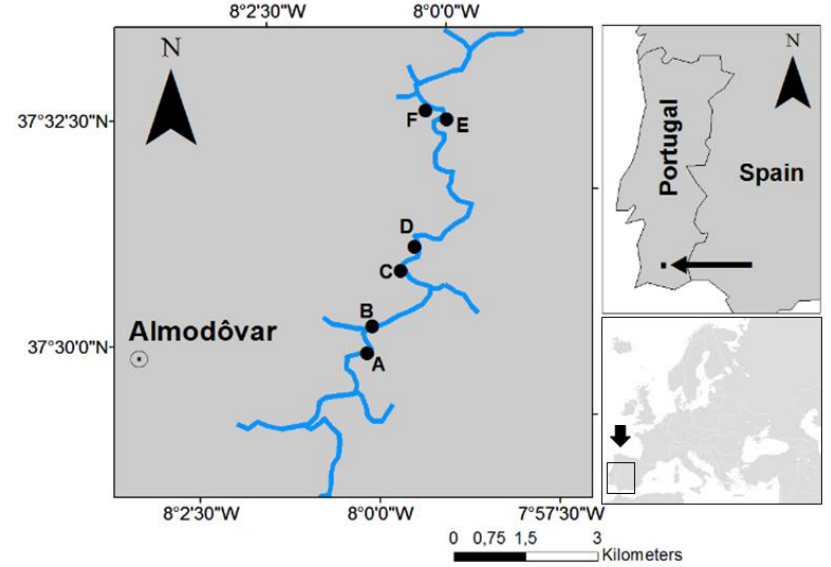
Figure 1. Location of the six permanent pools in the Oeiras river, flowing north in this section. Ossada Montante ( A ), Monte Ossada ( B ), Monte Bentes ( C ), Pego do Inferno ( D ), Pego do Linho ( E ) and Pego dos Cágados ( F ).